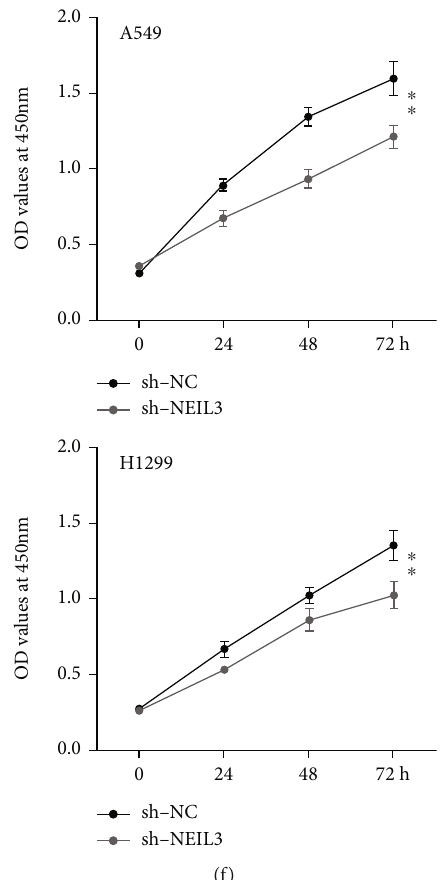
Figure 4: NEIL3 promoted lung cancer cell proliferation. Notes: (a) expression levels of NEIL3 in lung cancer cell lines; (b) expression levels of NEIL3 in lung cancer tissue; (c, d) qRT-PCR was performed to evaluate the knockdown e ffi ciency of NEIL3 in cancer cell lines; (e) colony formation assay was performed in control and NEIL3 knockdown cells; (f) CCK8 assay was performed in control and NEIL3 knockdown